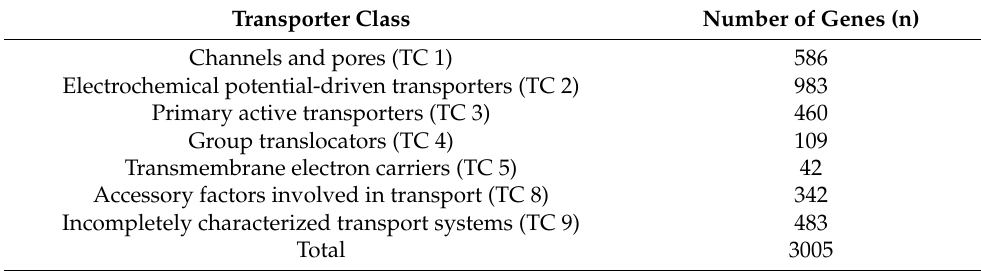
Table 4. Genes predicted to code for transporters in the genome of Aspergillus affinis CMG